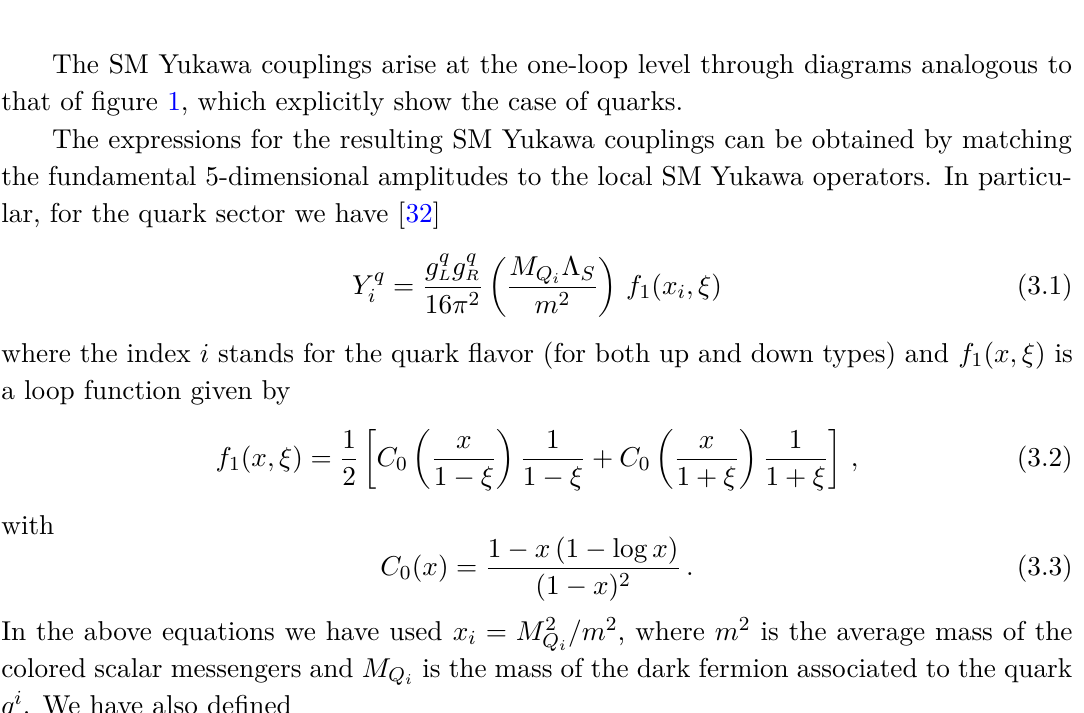
Figure 1 . The diagrams responsible for the radiative generation of the Yukawa couplings of up- type quarks (a) and down-type quarks (b). The black circle on the external scalar line implies that the field H is set to its vacuum expectation value v . The blue dot on the dark fermion line (in S S red), instead, represents a mass